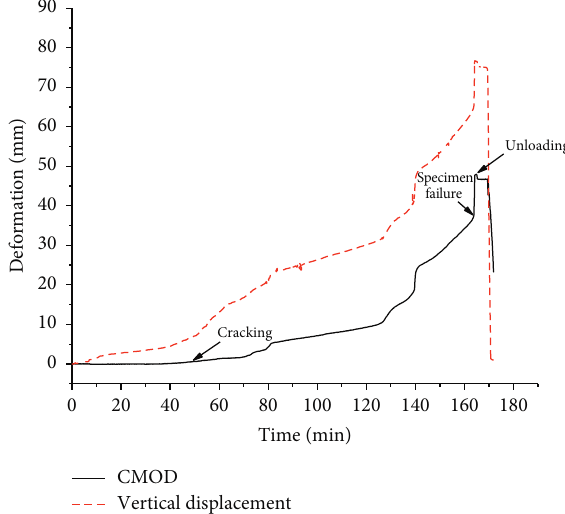
Figure 9: CMOD and vertical displacement of the specimen.